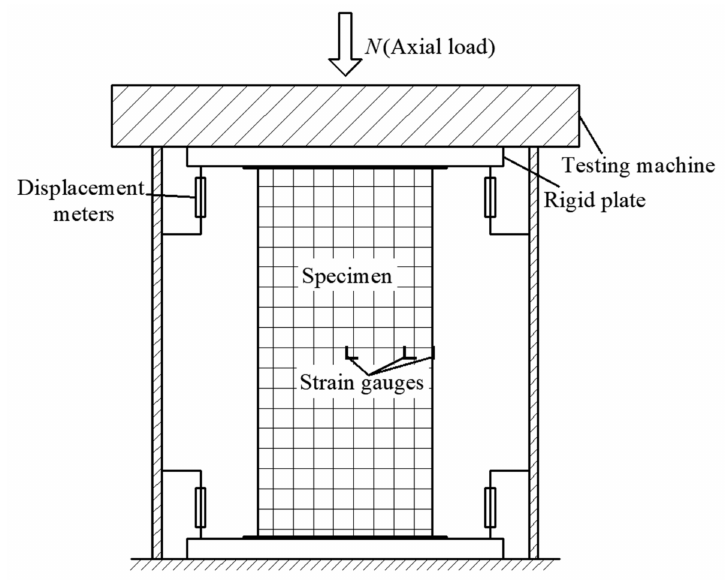
Figure 3. Compressive test setup.